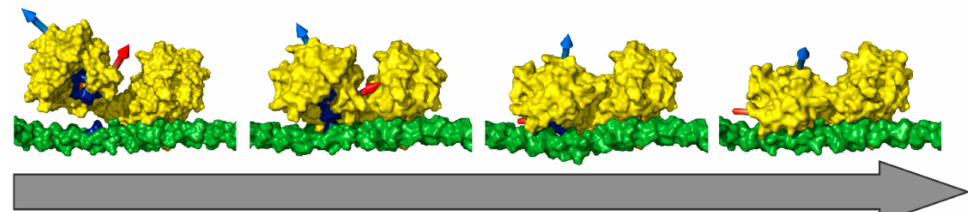
Figure 2. Modeling of the steps preceding the mechanism of collagenolysis. From left to right, one of the structures with the highest Maximum Occurrence (MaxOcc), two morphing intermediates, and the structure of the first step of the mechanism of collagenolysis. In yellow is the surface representation of matrix metalloproteinase-1 (MMP-1), in blue is the MMP consensus sequence HEXXHXXGXXH, in orange is the MMP-1 catalytic Zn 2 + , in green is the surface of a triple helical peptide model (THP) representative of collagen type I, and in blue is the THP cleavage site (Gly-Ile) of the first chain. The blue and red arrows indicate the directions of helices hA and hC, respectively, to facilitate visualizing the movement of the catalytic (CAT) domain with respect to the hemopexin-like (HPX) domain and the THP. The THP sequence is (GPO)4-GPQGIAGQRGVVGLO-(GPO)4 (where O is 4-hydroxyproline), based on the human α 1(I) collagen chain. Adapted from Reference